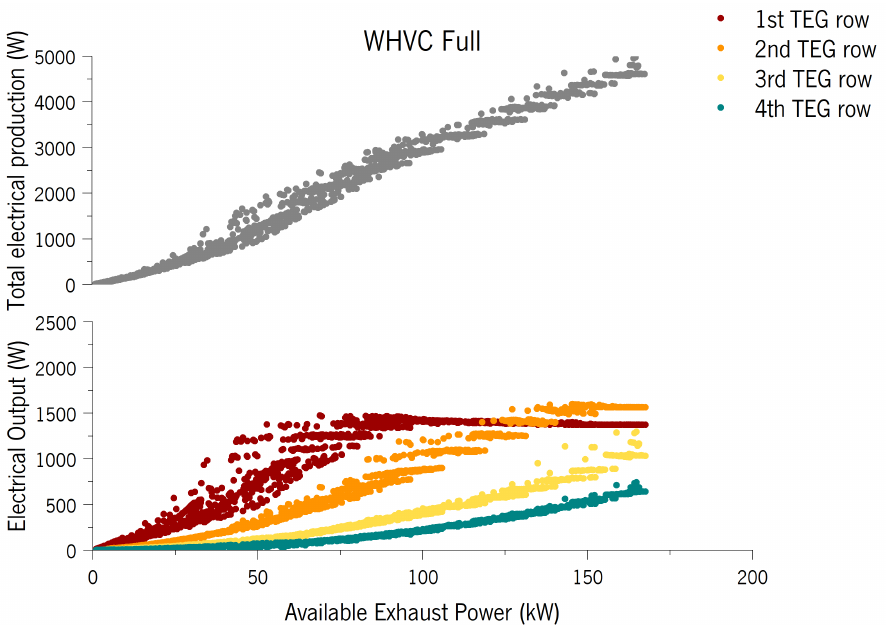
Figure 11. Power distribution along the system modules for WHVC driving cycle with 25.5 t.